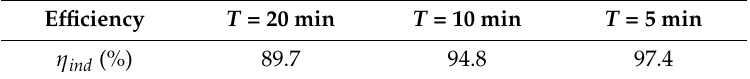
Table 9. Efficiency system for the first configuration varying the charging time.